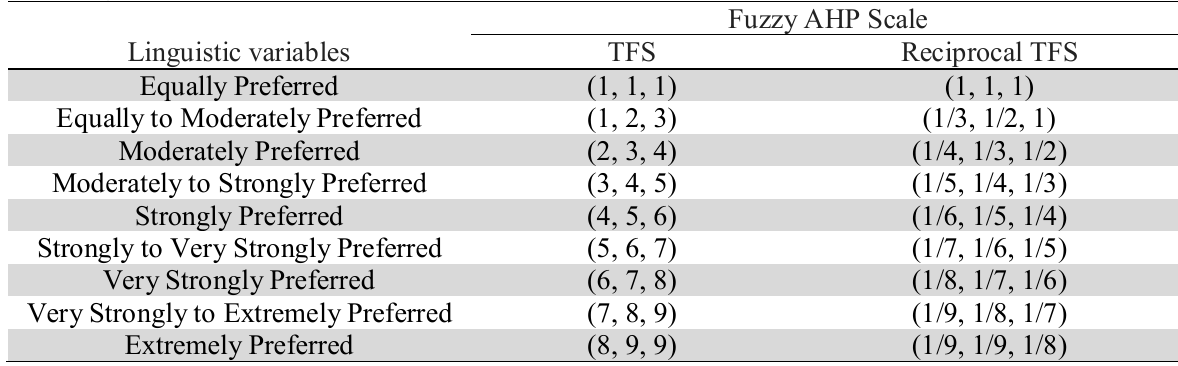
The linguistic terms